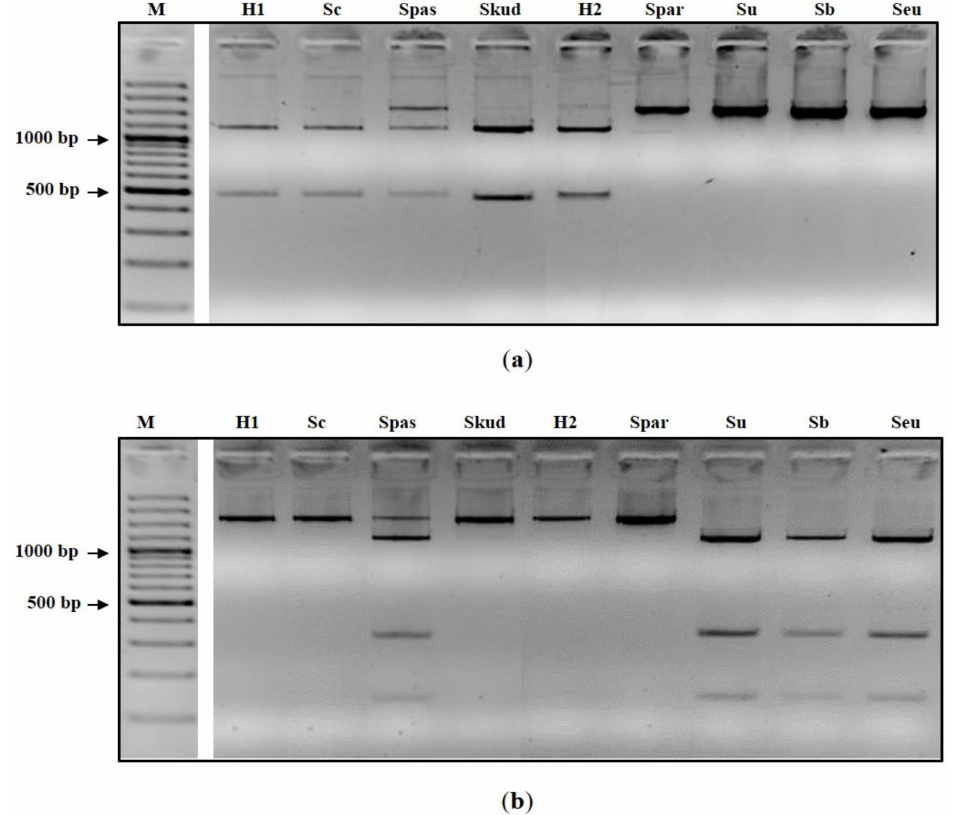
Figure 4. Patterns of HIS4 PCR fragments after digestion with Ecor V ( a ) and Pst I ( b ) restriction enzymes, H1, H2: isolates investigated, Sb: S. bayanus DBVPG 8001, Sc: S. cerevisiae CBS 1171, Skud: S. kudriavzevii CBS 8840, Spar: S. paradoxus CBS 432, Spas: S. pastorianus VTT-A63015,